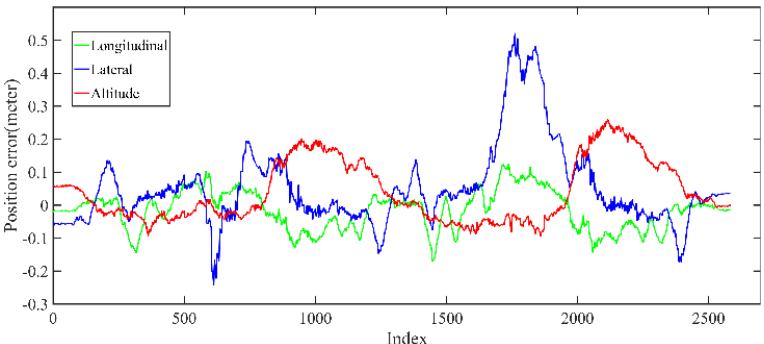
Figure 30. Field test NO.4. Two laps under curve driving scenario localization test trajectory comparison. The comparison of fused trajectory with groundtruth.